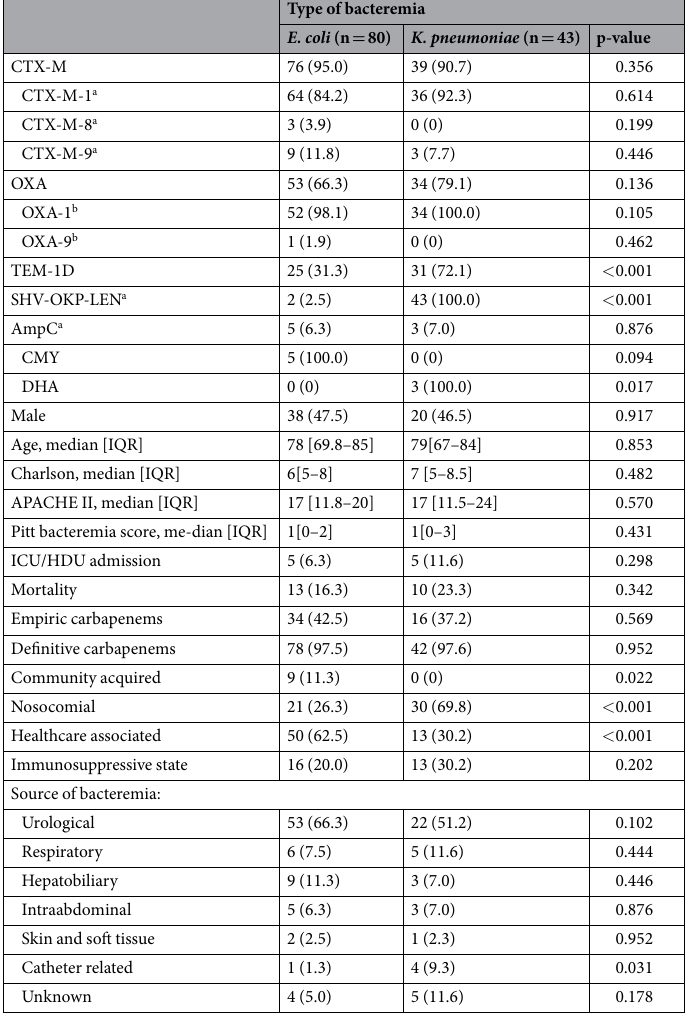
Table 1. Beta-lactamases and clinical characteristics of patients with third-generation cephalosporin-resistant E. coli and K. pneumoniae bacteremia. a Third-generation cephalosporin-resistant variants. b Variants reported to hydrolyze broad-spectrum cephalosporins slightly 65 ; OXA-1 confers resistance to piperacillin-tazobactam 66 , while OXA-9 has unknown effect on piperacillin-tazobactam. Data are no. of patients (%), unless otherwise indicated. IQR: Inter-quartile range; ICU: intensive care unit; HDU: high dependency unit.